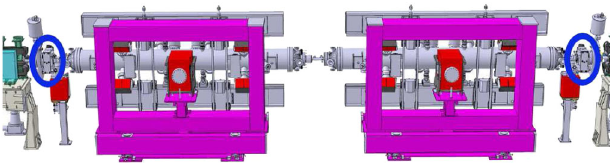
FIG. 6. Example of vertical apparent emittance abrupt jumps (top) following two ID gap movements (bottom). In the upper graph the emittance is measured at 12 monitors (red lines) and is depicted by the blue line. The the corresponding mean value (cid:2) (cid:3) FIG. 7. Drawings of an ESRF straight section housing two y corresponding apertures of ID6 and ID13 are reported in the undulators. Corrector steerers (blue ellipse) are placed at both lower plot.